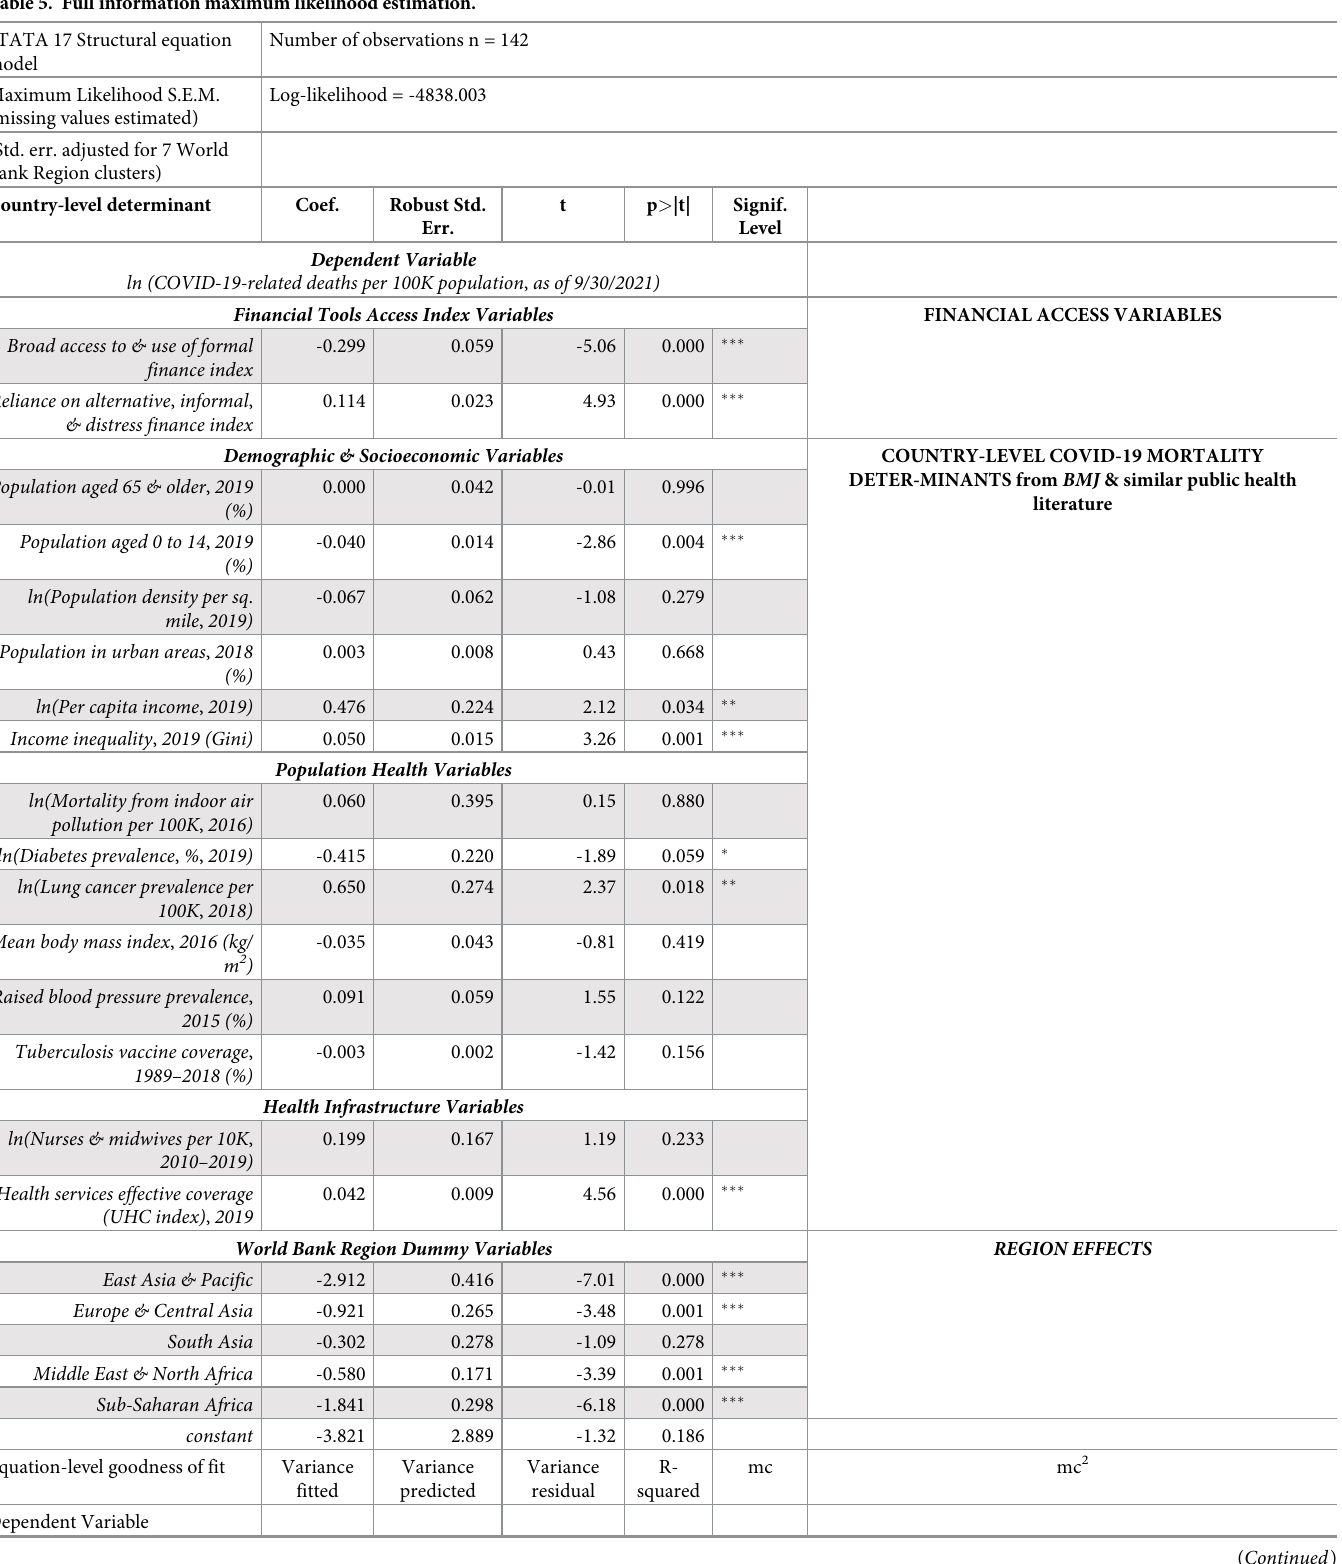
Table 5. Full information maximum likelihood